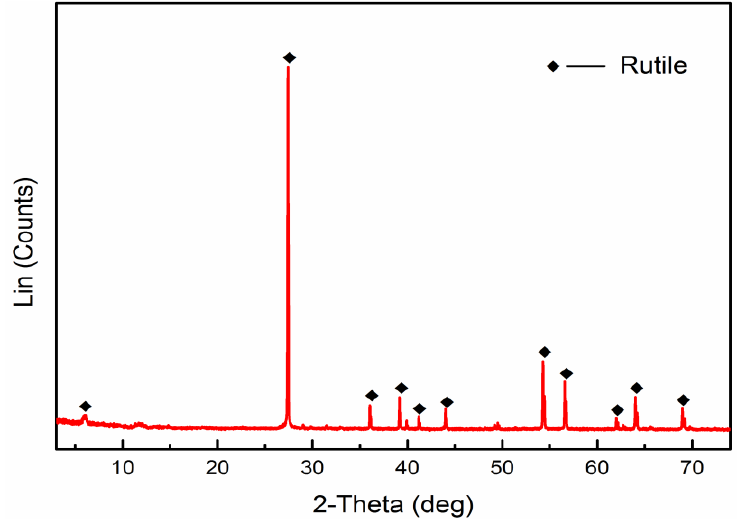
Figure 2. XRD pattern of rutile. Table 1. Multi-element analysis of pure rutile mineral (%).